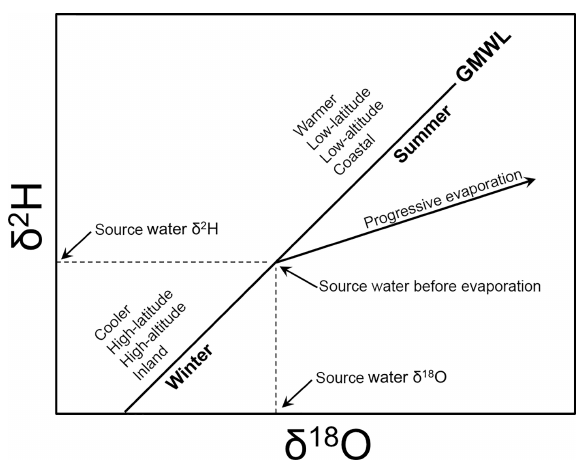
Figure 1. The generalized relationship between δ 2 H and δ 18 O val- ues measured in precipitation worldwide. The spatial and seasonal trends along the global meteoric water line (GMWL) are described. The evaporation line is denoted by the line labeled “progressive evaporation”, and samples that have undergone more evaporation will move away from the GMWL along this line. The original δ 2 H and δ 18 O values of the evaporated water’s source can be determined by finding the intersection of the evaporation line with the GMWL. Base figure redrawn from sahra.arizona.edu.